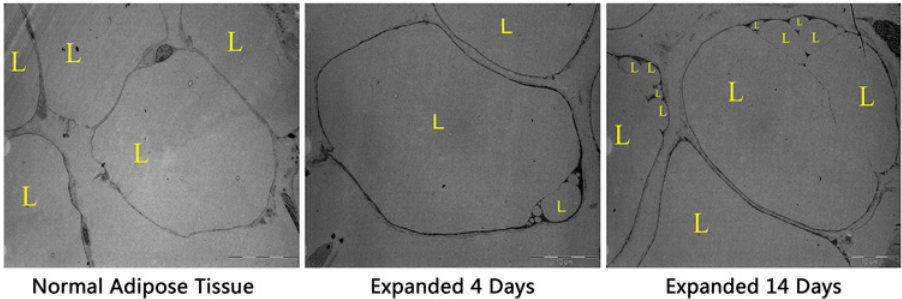
Fig 4. TEM analysis of the expanded tissue. During the expansion, the number of adipocytes with monolocular lipid droplets increased over time. L, lipid droplet.